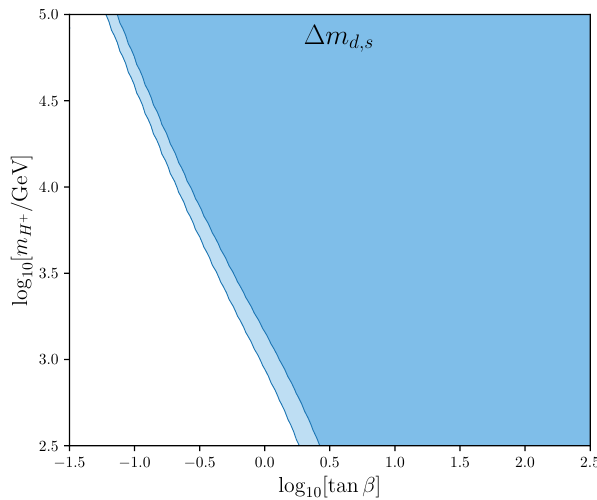
Figure 4 . Contour plot of the allowed 2HDM-I parameter space in the ( tan β − m the combined fit to ∆ m d,s . The darker contour indicates allowed parameter space at 1 σ confidence, and the lighter at 2 σ